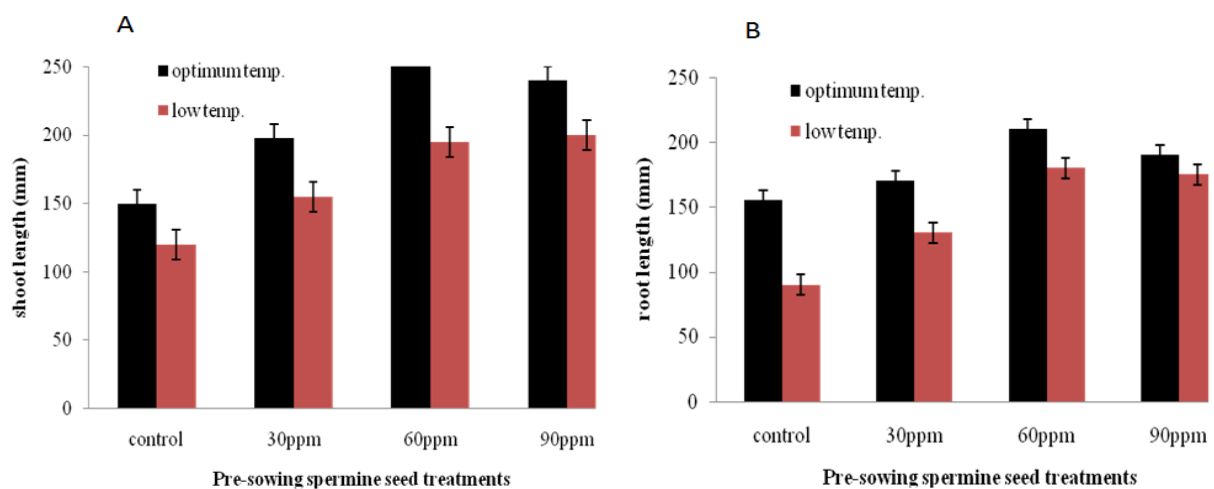
Fig. 2. Effect of spermine application on shoot (A) and root (B) length of maize seedlings under optimum and low temperature conditions. Data are the mean value of three replications ± SE which represented by the vertical bar in each graph